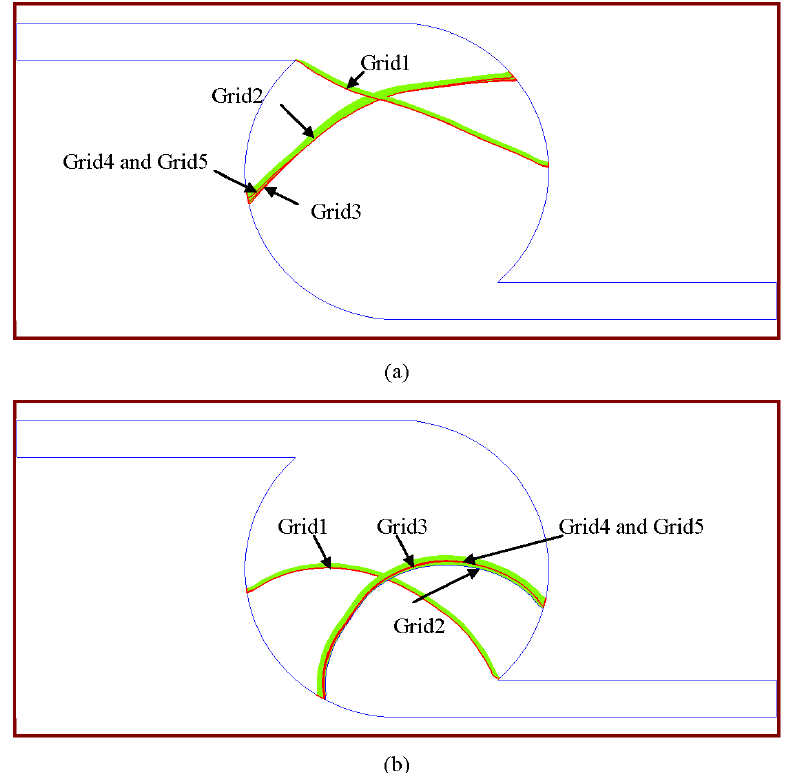
Figure 3. The shapes of the liquid fronts at times of ( a ) 0.02 s and ( b ) 0.04 s at an inlet flow velocity of 0.1 m/s at five mesh densities. Grid1: 1.2096 × 10 4 , Grid2: 3.0720 × 10 4 , Grid3: 5.6000 × 10 4 , Grid4: 9.6768 × 10 4 , and Grid5: 1.6033 × 10 5 .